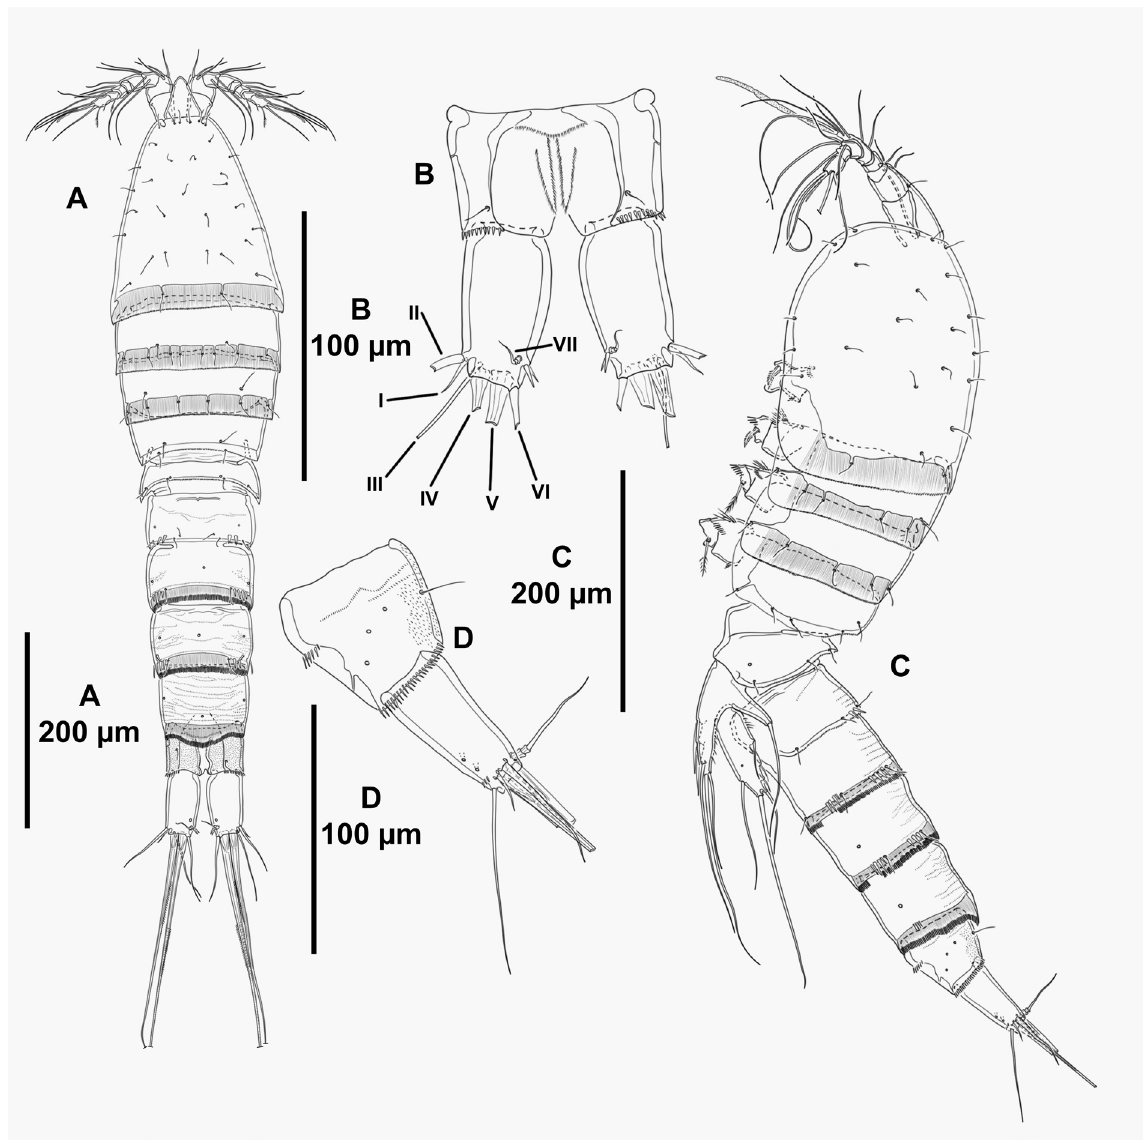
Fig. 1. Typhlamphiascus medici sp. nov., holotype, ♀ (ICML-EMUCOP-180119-40). A . Habitus, dorsal view. B . Anal somite and caudal rami, dorsal view. C . Habitus, lateral view. D . Anal somite and left caudal ramus, lateral